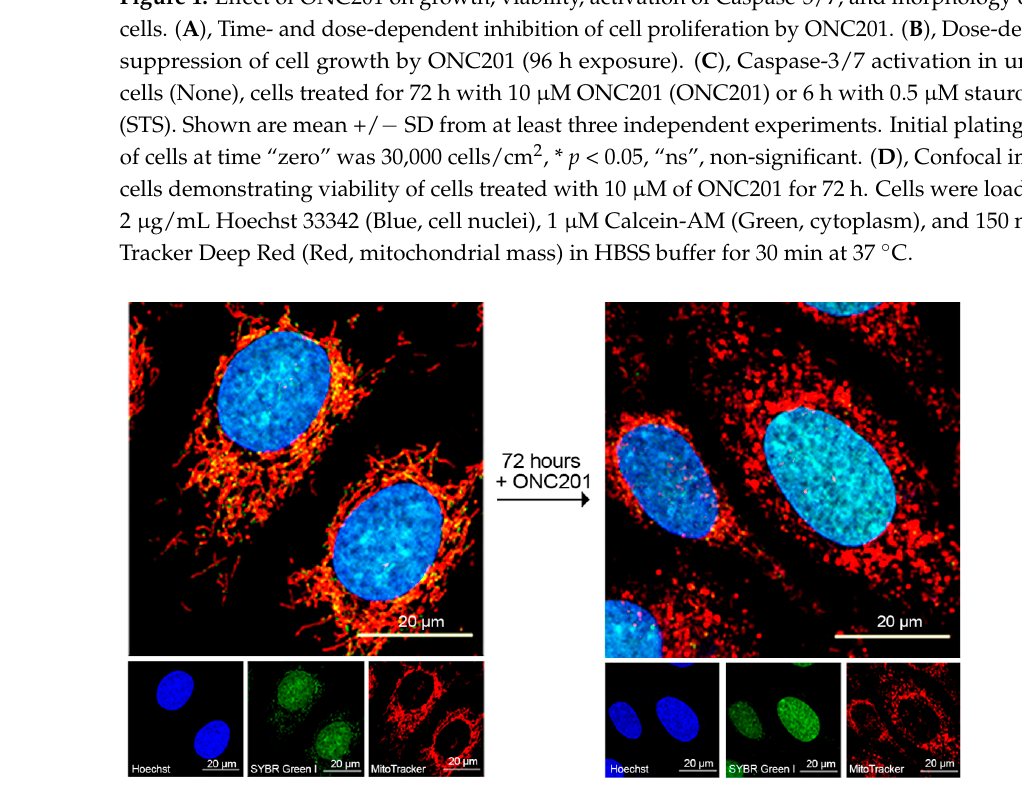
Figure 2. Effect of ONC201 on mitochondrial morphology and mtDNA content of BT474 cells. Confocal fluorescent images of BT474 before (left panel) and after exposure to single-dose 10 µM ONC201 for 72 h (right panel). Cells were loaded with Hoechst 33,342 (2 µg/mL), SYBR Green I (1:200,000 dilution), and MitoTracker Deep Red (150 nM) in HBSS buffer for 30 min at 37 °C. The small panels show individual images of nuclei (blue, Hoechst 33342), mitochondrial nucleoids and nuclear DNA (green, SYBR Green 1), and mitochondria (red, Mito Tracker Deep Red). Since ONC201 treatment induces mitochondrial damage and inhibits proliferation without induction of cell death, we examined the long-lasting consequences of a single- dose treatment on the number of mitochondrial nucleoids and mitochondrial morphol- ogy. For this purpose, we used the treatment protocol described in Materials and Methods and illustrated in Supplementary Figure S1. Briefly, cells were treated with a 10 µM single dose of ONC201 for 24, 48, and 72 h; then, the drug was removed from the incubation media, and cells were incubated in the drug-free media for 120 h (5 days) with regular (every 24 h) incubation media replacement. Quantification of obtained images (Supplementary Figure S2) demonstrated that long-lasting consequences of ONC201 single-dose treatment depend on the duration of BT474 cell exposure to the drug. The 24 h exposure to ONC201 resulted in a decline in the number of mitochondrial nucleoids from 249 ± 52 to 155 ± 38 nucleoids per cell, and sub- sequent 120 h washout partially restored the number to 214 ± 46 nucleoids per cell (Figure 3A, 24 h). The 48 h exposure of BT474 cells to a single dose of ONC201 (10 µM) resulted in a decline in the number of mitochondrial nucleoids from 249 ± 52 (in control) to 78 ± 28 nucleoids per cell, and, after a subsequent 120 h washout, the average number of mito- chondrial nucleoids was 91 ± 72 nucleoids per cell. On the contrary, 72 h exposure to ONC201 led to a greater decline in the number of mitochondrial nucleoids (from 249 ± 52 to 84 ± 36 nucleoids per cell), and the subsequent washout resulted in a further drop up to 21 ± 11 nucleoids per cell (Figure 3A, 72 h). The ONC201-dependent reduction in nu- cleoids in BT474 cells (Figure 3A) correlated with the decreased content of mitochondrial DNA (mtDNA) in BT474 cells as demonstrated by q-PCR (Figure 3B). The ratio of mtDNA-encoded gene MT-ND1 (NADH-ubiquinone oxidoreductase chain 1) normalized to nuclear DNA encoded gene ACTB ( β -actin), demonstrating that 24 h ONC201 treatment decreased this ratio from 1.09 ± 0.51 in non-treated BT474 cells to 0.64 ± 0.29 and remained at the same level after washout (Figure 3B, 24 h), whereas 72 h treatment resulted in a drop to 0.41 ± 0.20 with a further decrease to 0.21 ± 0.01 after washout (Figure 3B, 72 h).